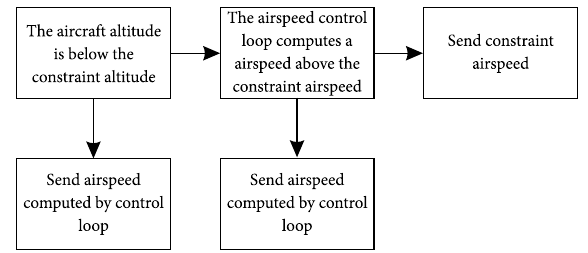
Fig. 2. Speed/altitude check